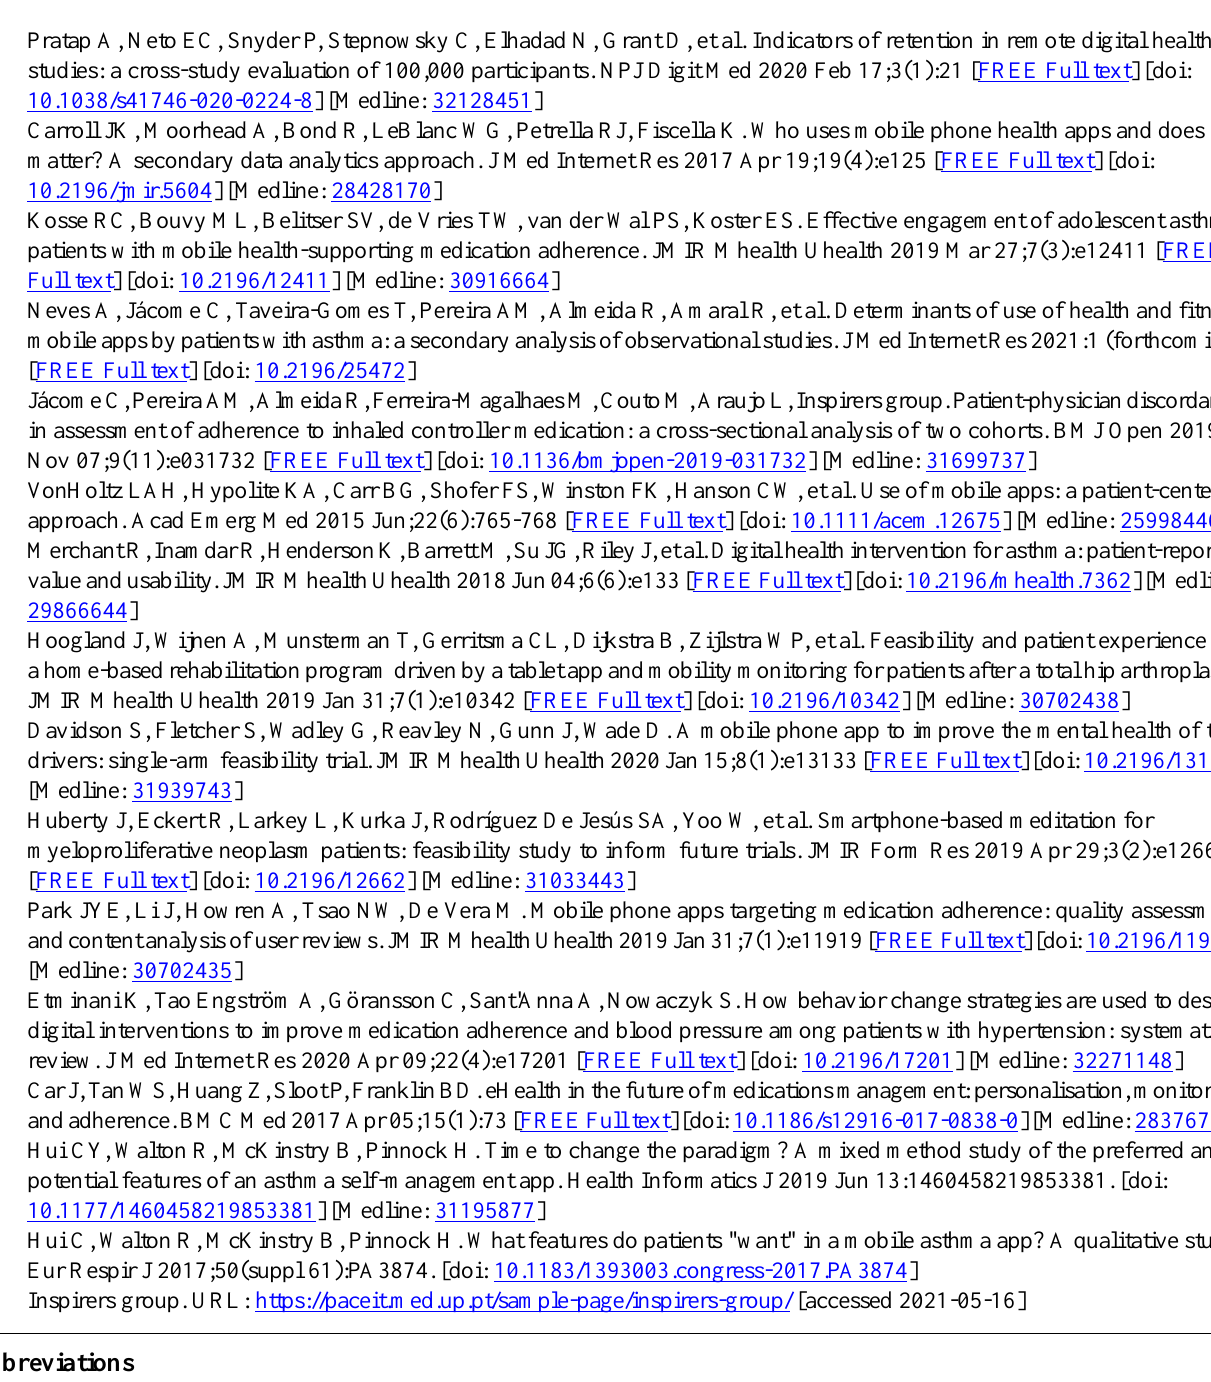
Abbreviations CARAT: Control of Allergic Rhinitis and Asthma Test EQ-5D: EuroQol 5-Dimension questionnaire GINA: Global Initiative for Asthma mHealth: mobile health STROBE: Strengthening the Reporting of Observational Studies in Epidemiology VAS: visual analog